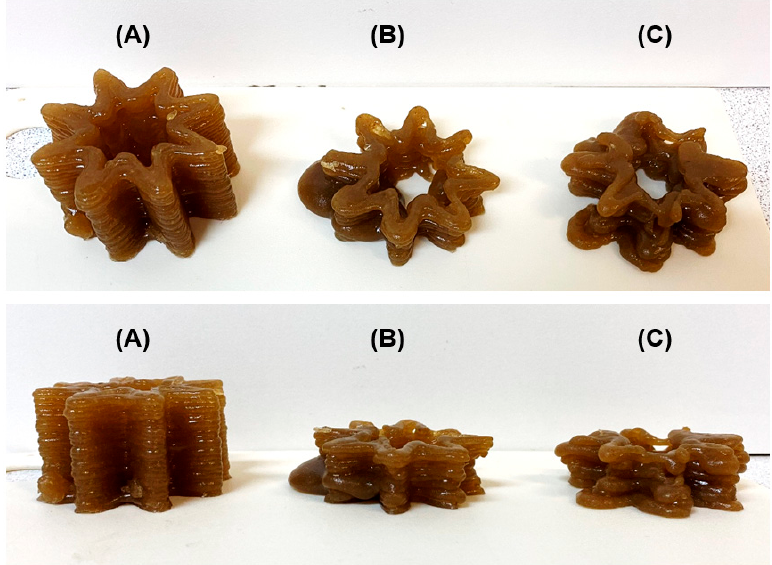
Figure 4. Representative results of the 3D printing experiments using LA16 ‐ 33 ( A ), LA16 ‐ 50 ( B ), and LA16 ‐ 66 ( C ) inks. The top row of photographs is an angled top view; the bottom row is a side view.